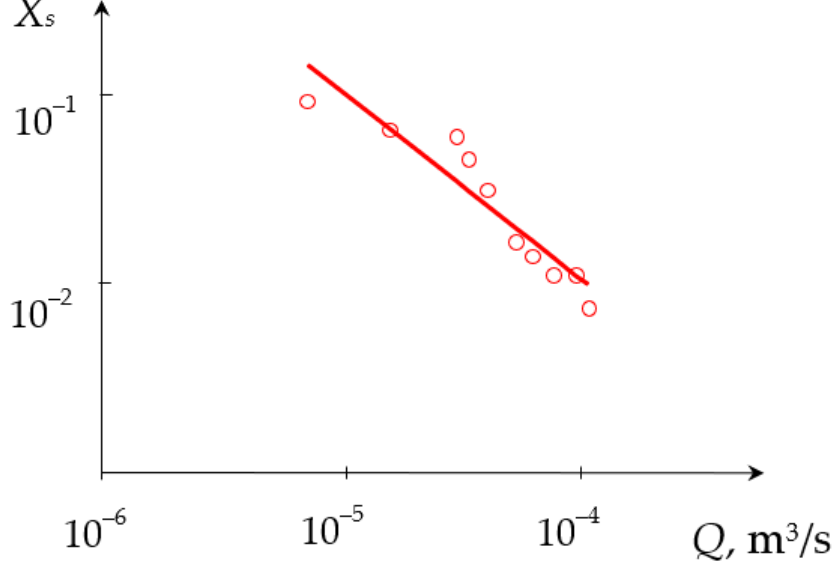
Figure 13. Dependence of the segregation index X s on the total flow rate Q 2 (m 3 /s) for liquids sup‑ plied to the upper tangential and lower tangential branch pipes (TU1, TL2). Points—experimental data, line— X s = A 2 Q n 2 , where A 2 = 0.056, n 2 = − 0.974.